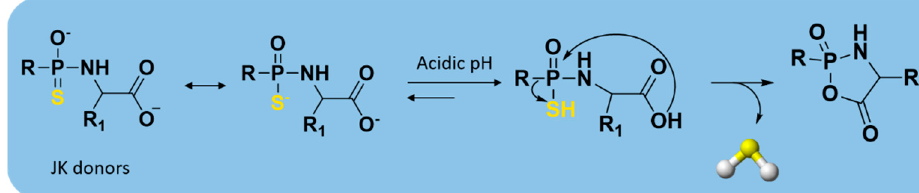
Figure 8. H 2 S-releasing mechanism from JK donors.